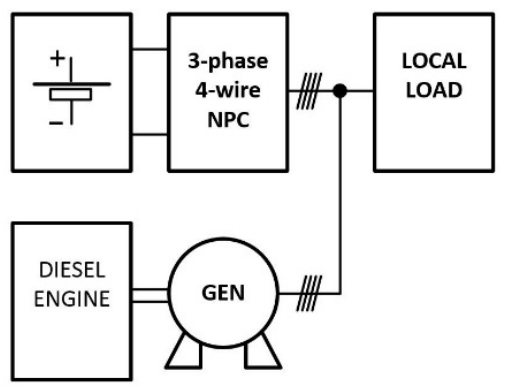
Figure 1. Microgrid with Diesel generator and an energy storage.